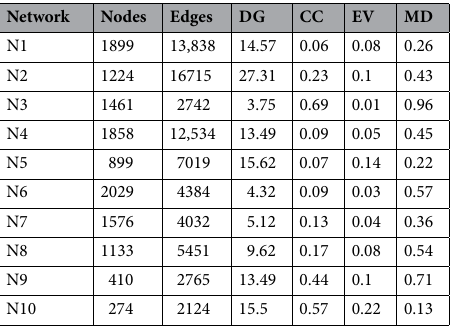
Table 1. Main network characteristics for Networks N1–N10, including number of nodes and edges, mean degree (DG), global clustering coefficient (CC), mean eigenvector centrality (EV), and modularity